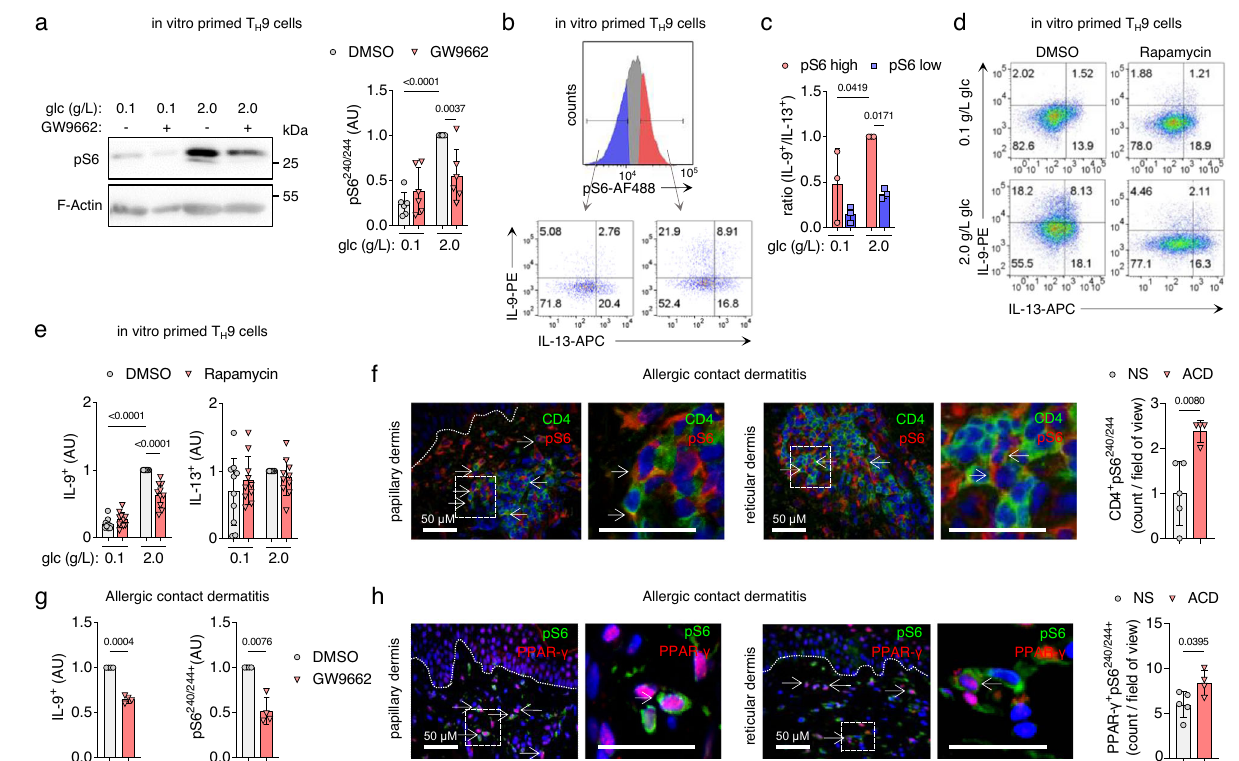
Fig. 4 | mTORC1 integrates bioenergetics with effector function in T H 9 cells. a Western blot analysis of pS6 in T H 9 cells primed in vitro. b In vitro primed T H 9 cells were cultured in glucose of different levels for 48h, and pS6 and IL-9 were measured 18h after activation with α CD3/CD2/CD28 by fl ow cytometry. The his- togramshowspS6positivecells,splitintohighandlowpS6.Dot-plotsrepresentIL- 9 + /IL-13 + clusters. c The IL-9 + /IL-13 + ratio in T H 9 cells primed in vitro from b . d , e Cytokine expression of in vitro primedT H 9 cellsafter incubation in glucose of different levels and rapamycin for 48h, measured as in b . f Immuno fl uorescence staining for CD4 and pS6 on skin samples of allergic contact dermatitis (ACD) and quanti fi cation of CD4 + pS6 + cells in normal skin (NS) and ACD skin samples. Scale